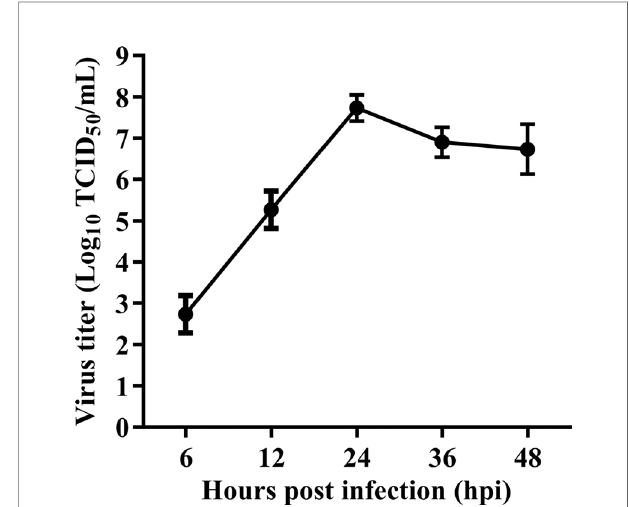
FIGURE 1 | Replication kinetic of velogenic NDV strain Herts/33 in HeLa cells. HeLa cells were infected with velogenic NDV strain Herts/33 at an MOI of 1. Subsequently, the cellular supernatants were taken at indicated time points and titrated by TCID 50 assay in DF-1 cells. Data are from three independent experiments and presented as the means ± SD.